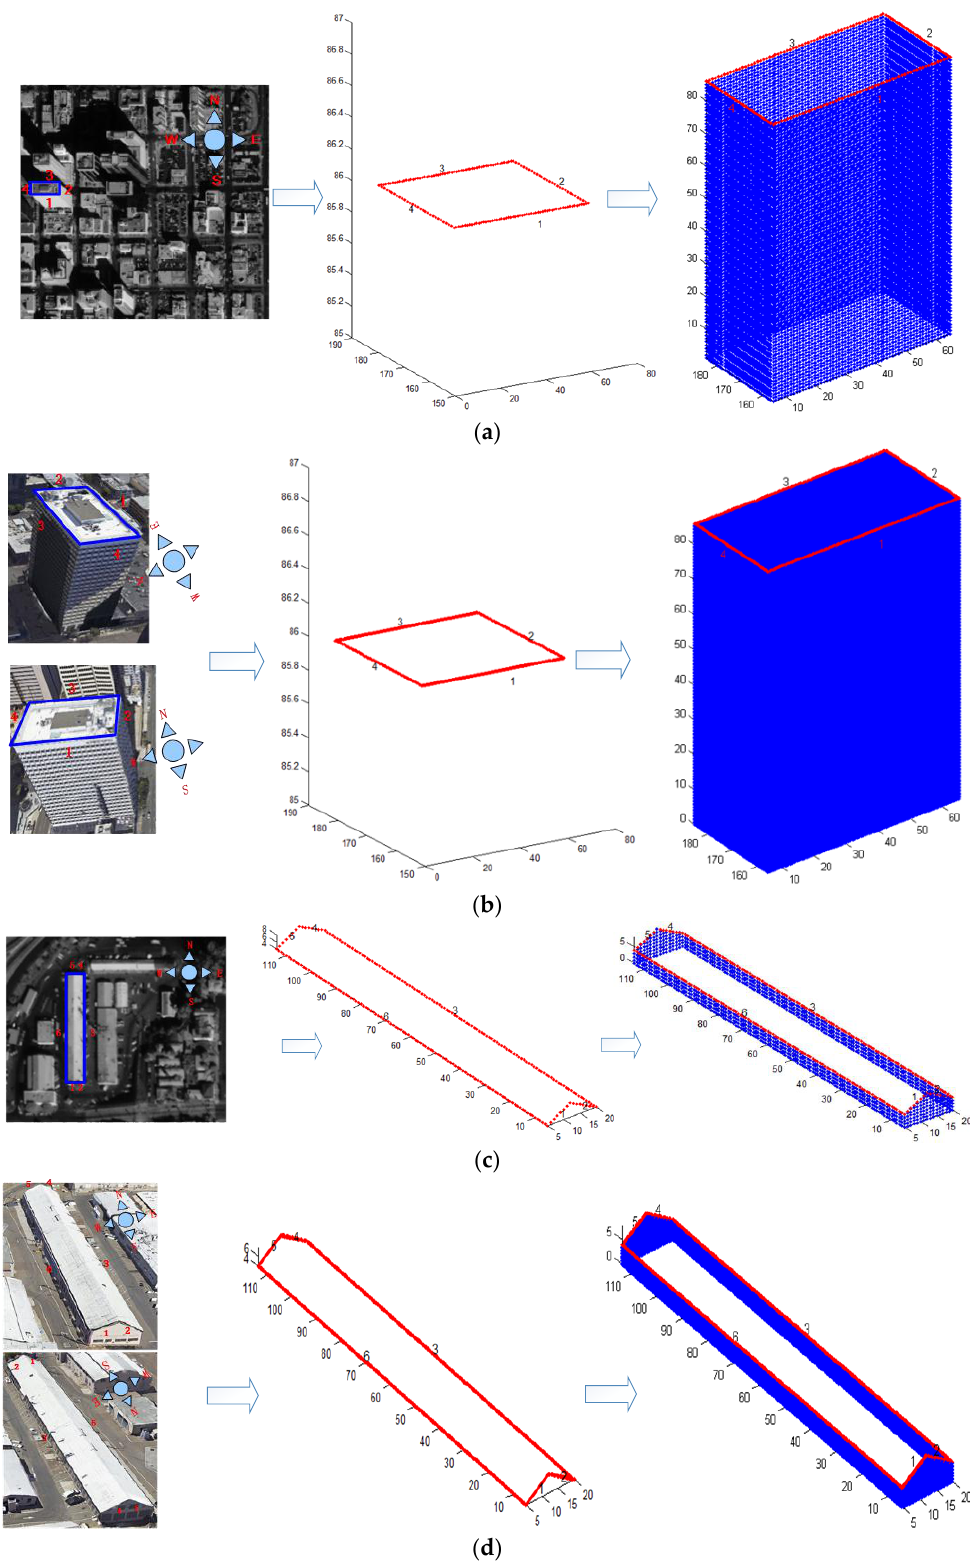
Figure 16. Facade generation of buildings in different cases. ( a ) Facade generation of Building A by satellite texture-images; ( b ) facade generation of Building A by airborne-like texture-images; ( c ) facade generation of Building B by satellite texture-images; ( d ) façade generation of Building B by airborne-like texture-images.